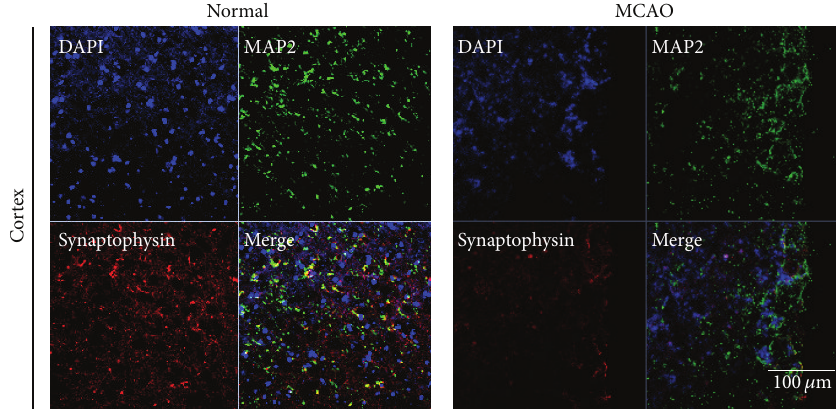
Figure 1: Immunochemical image for confirmation reduced synaptophysin expression in MCAO mouse brain. Immunochemical images showed that synaptophysin-positive cells (red) were decreased as expressed in MCAO mouse cortex. In addition, immunochemical images showed that MAP2- (considered as the neuron specific microtubule protein) positive cells (green) were strongly decreased in MCAO mouse cortex compared to the normal group. We used 5 rats in each groups for study. Each measurement included 3 repeats per animal. Scale bar = 100 𝜇 m, synaptophysin: red, MAP2: green, 4 󸀠 , 6-diamidino-2-phenylindole (DAPI): blue, normal: normal control group, and MCAO: reperfusion 24 hr after MCAO injury.